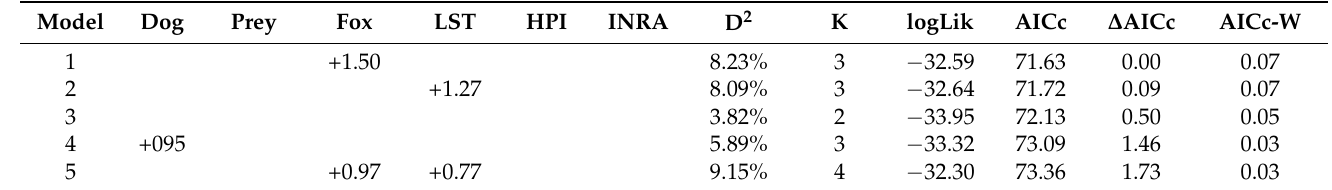
Table 5. Exploratory analysis of potential explanatory variables for observed variability in the apparent occurrence of puma ( Puma concolor ). Only the best five models, as ranked by AICc val- ues, are shown. Positive/negative signs indicate variables and effects considered by each model. H = landscape, L = location, LST = livestock, HPI = human presence index, INRA = relative integrated anthropization index, D2 = explained deviance, K = number of estimated parameters, logLik = loge likelihood, AICc = second order Akaike information criterion, AICc-W = Akaike weight.